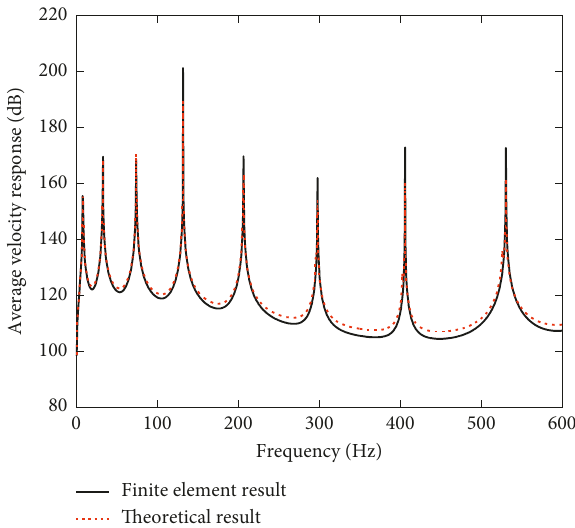
Figure 5: The comparison of average velocity response by theory and finite element method for the finite